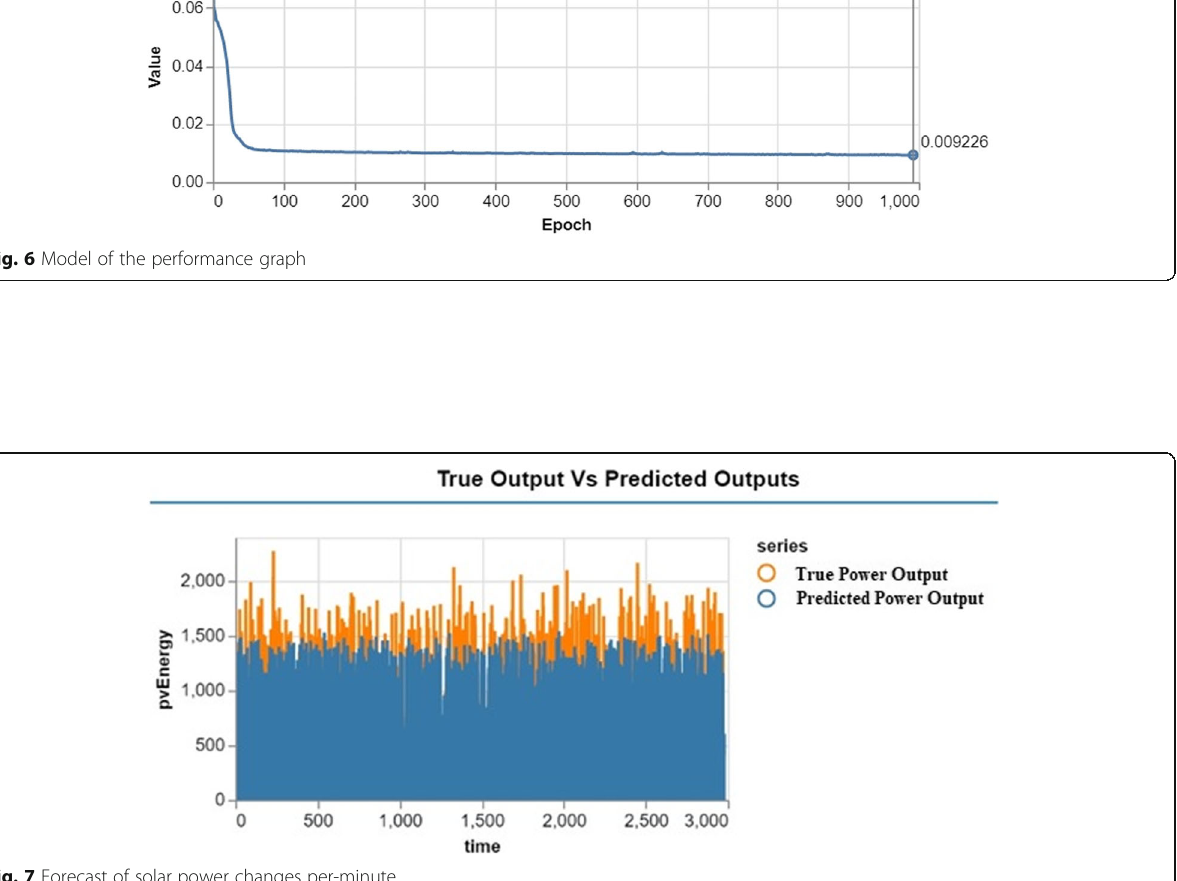
Fig. 7 Forecast of solar power changes per-minute